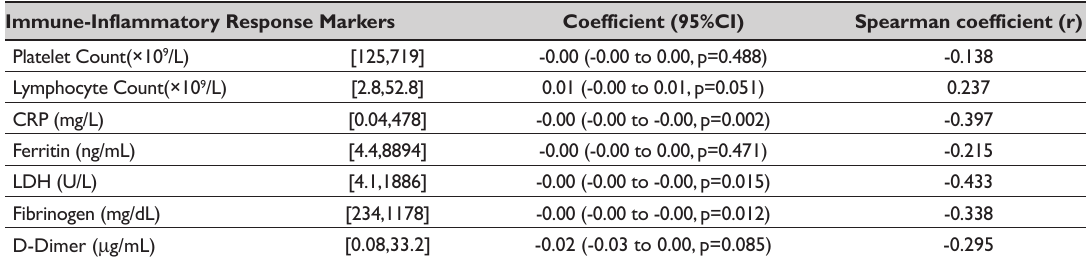
Table 5: Univariate linear regression models of the association between serum vitamin C levels and immune-inflammatory response biochemical markers Immune-Inflammatory Response